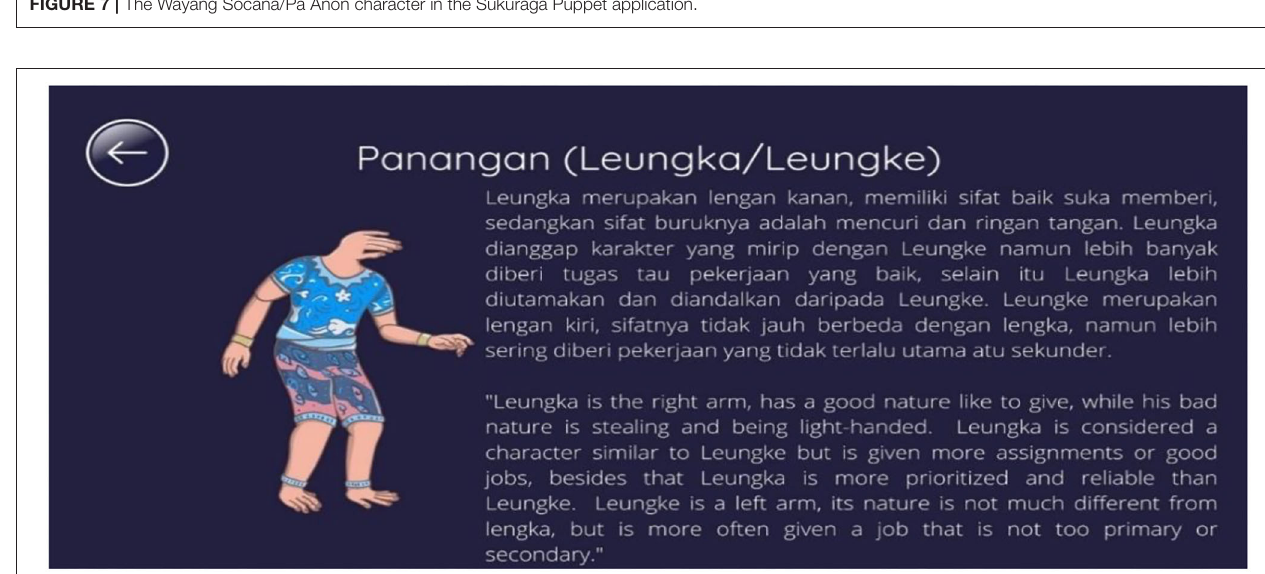
FIGURE 8 | Leungka figures in the Puppet Sukuraga